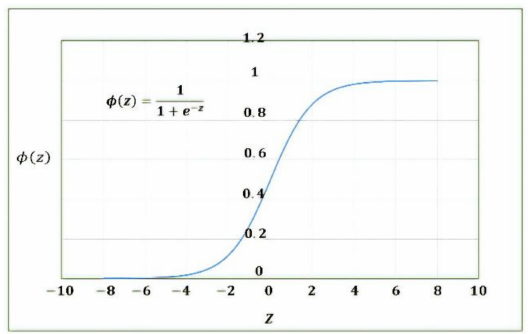
Figure 8. Sigmoid activation function.